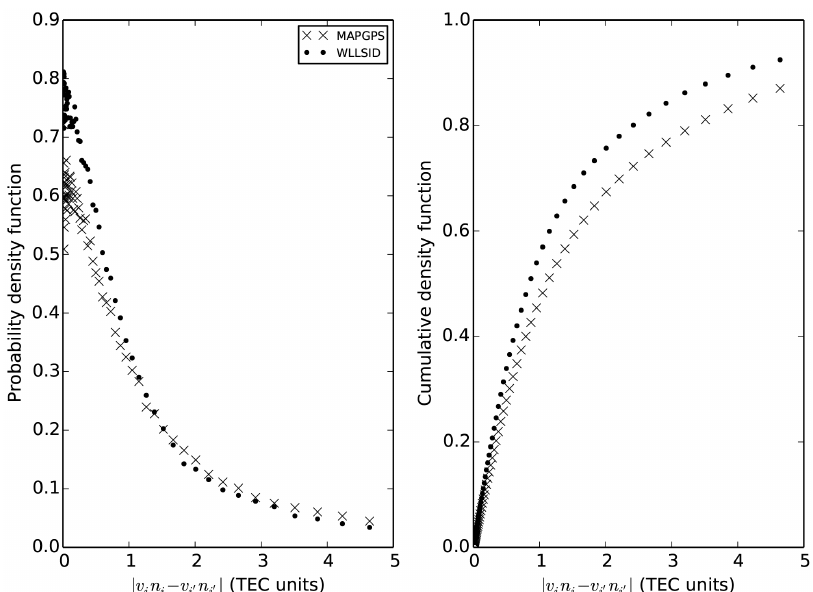
Figure 5. Probability density function and cumulative density functions for 192360 coincidences where vertical TEC was measurement within the same 30s time interval and have pierce points less than 50km apart from one another. The new method (labeled as WLLSID) has significantly more < 1 TEC unit differences than the old